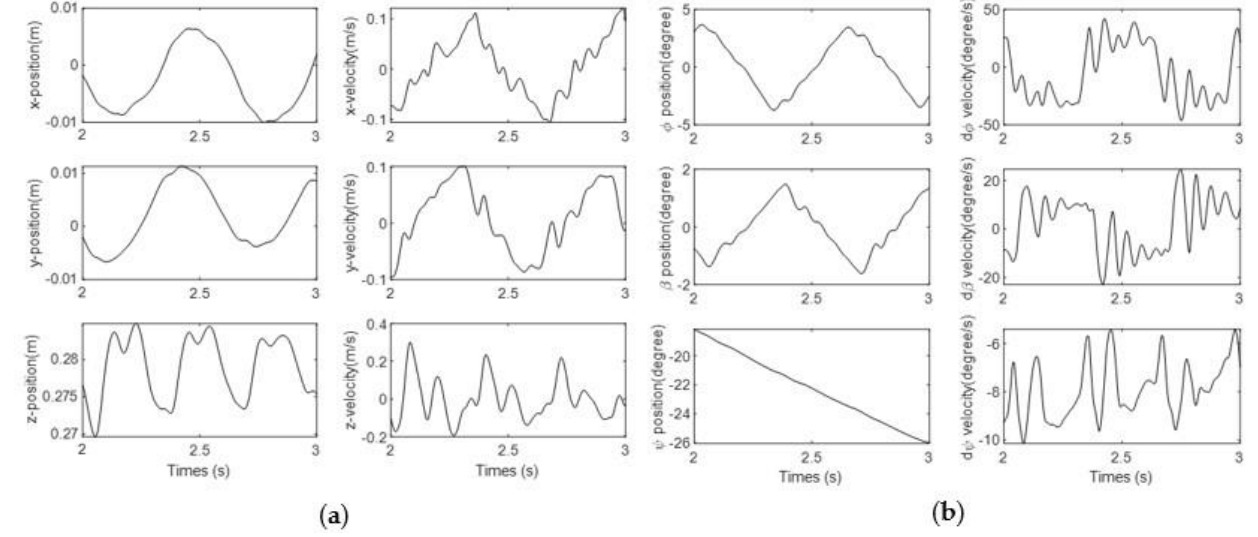
Figure 17. ( a ) Displacement response of the robot’s 90 ◦ rotation ( b ) The velocity response of the robot’s 90 ◦ rotation. Table 8. Accuracy errors of shots fired from the firefighting robot at targets while making a right turn maneuver with PID and